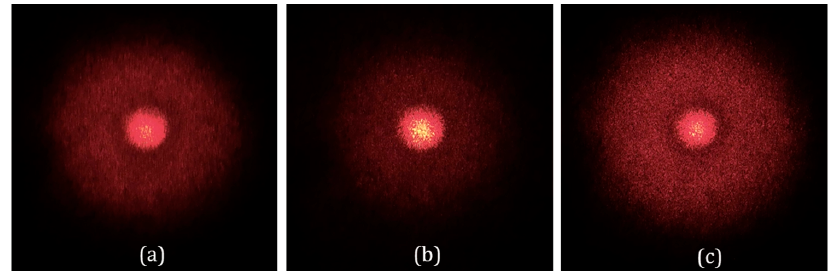
Figure 6. Transmitted patterns of the incident He-Ne probe beam at normal incidence through the PDLC film with large droplets at ( a ) 0, ( b ) 7, and ( c ) 100 V. The screen is placed around 30 cm behind the sample.